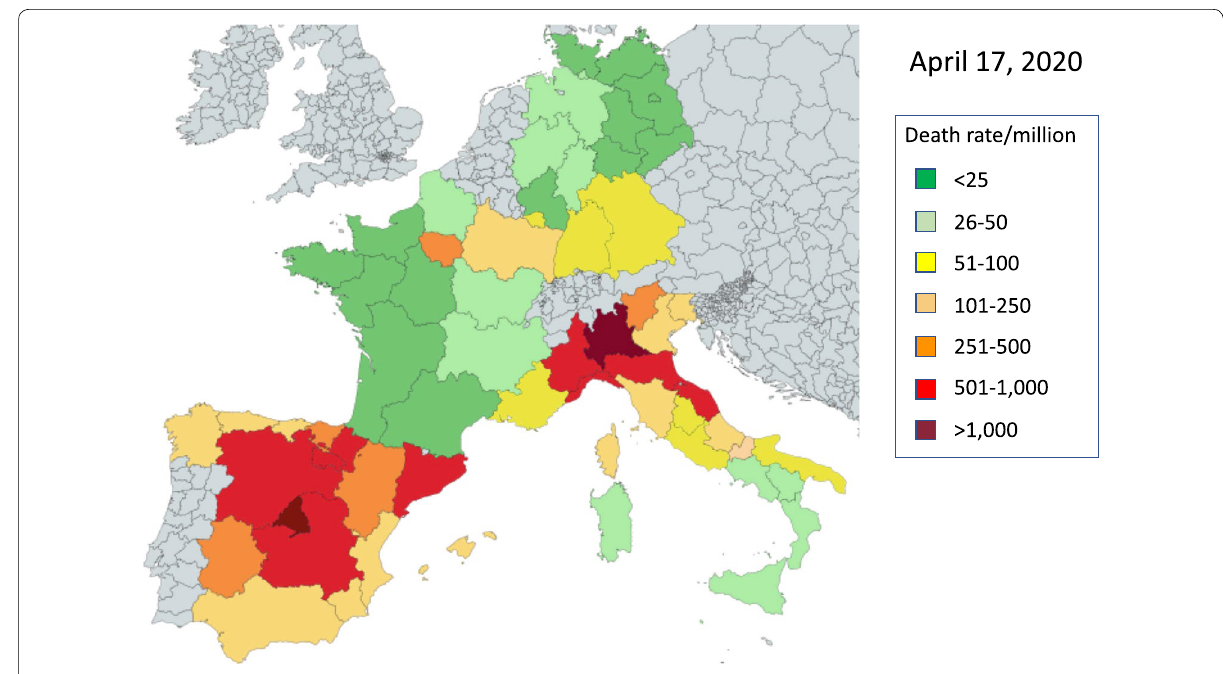
Fig. 2 Regional COVID‑19 death rates per million in four European countries